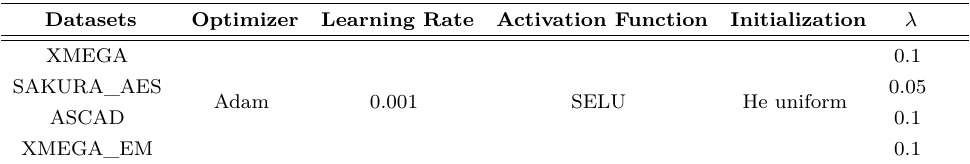
Table 2: Choice of